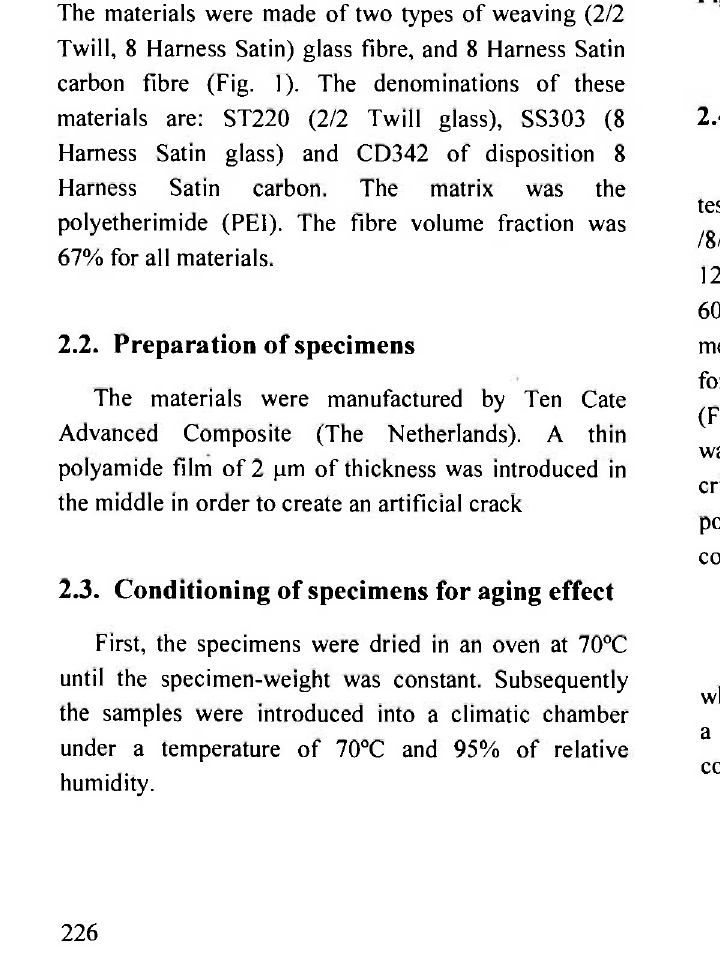
Fig. 1: Photographs of weaving fabrics: 2/2 Twill, 8H